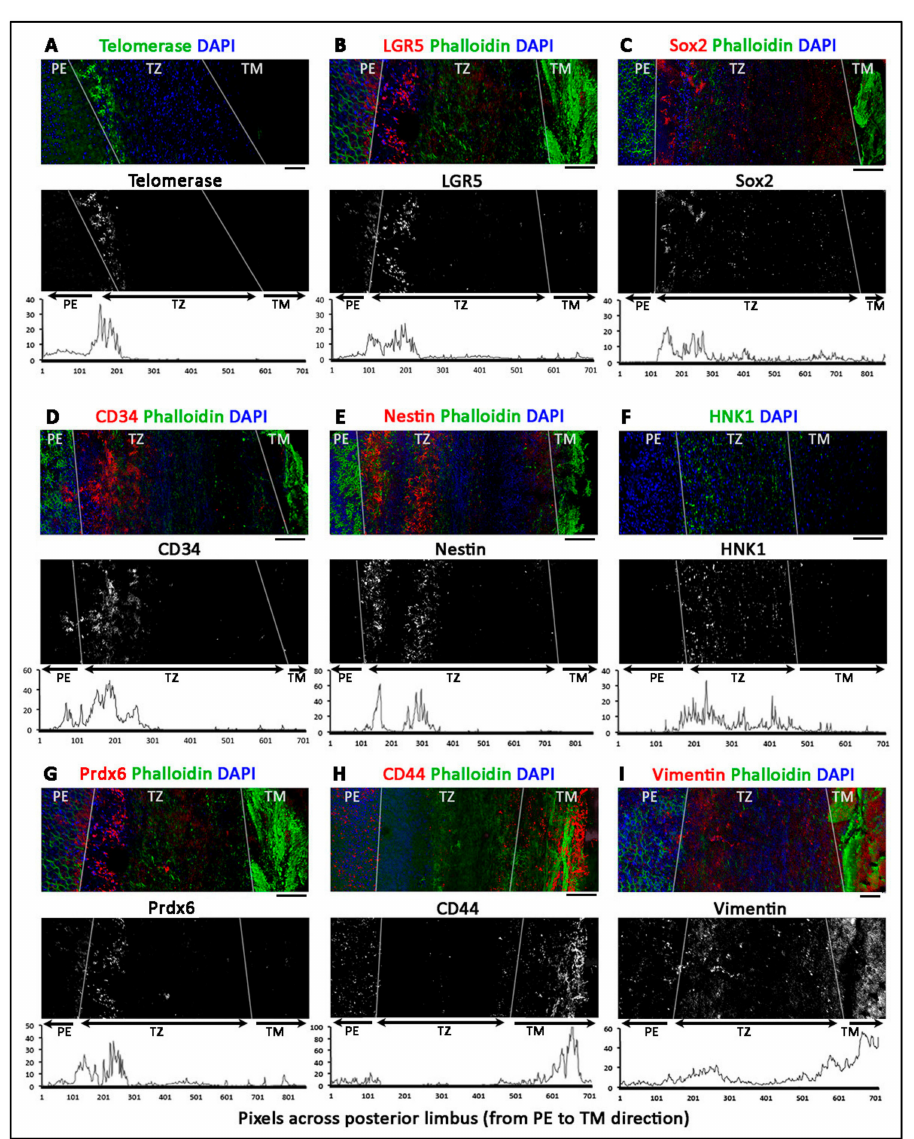
Figure 3. Z-series reconstructed confocal images showing the expression of stem cell markers in human transition zone (TZ), peripheral endothelium (PE) and trabecular meshwork (TM). The expression of ( A ) telomerase (TERT), ( B ) Lgr5, ( C ) Sox2, ( D ) CD34, ( E ) nestin and ( G ) Prdx6 were more expressed in the inner TZ. ( F ) HNK1 and ( I ) vimentin were detected in the entire TZ region. In contrast, outer TZ and TM had ( H ) CD44 and vimentin signal. White lines delineate borders between TM, TZ and PE. The top images represent the original colored confocal pictures, the middle grey-scaled images are single antibody-specific channel after threshold adjustment and the bottom graphs are the signal intensity profiles from PE across TZ to TM ( x -axis represents distance in pixels and y -axis is the relative intensity levels). Scale bars: 50 µ